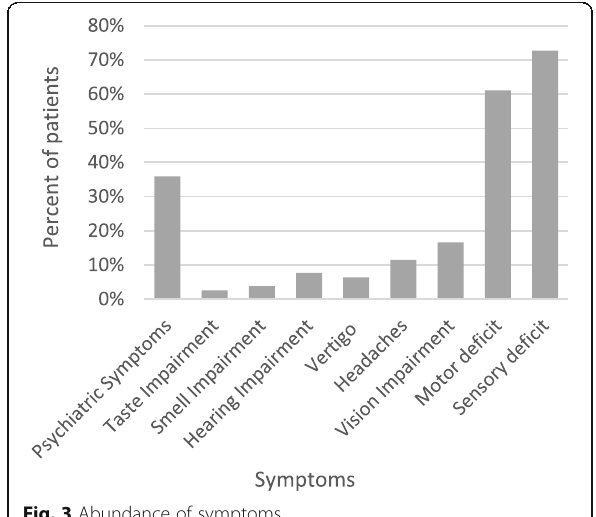
Fig. 3 Abundance of